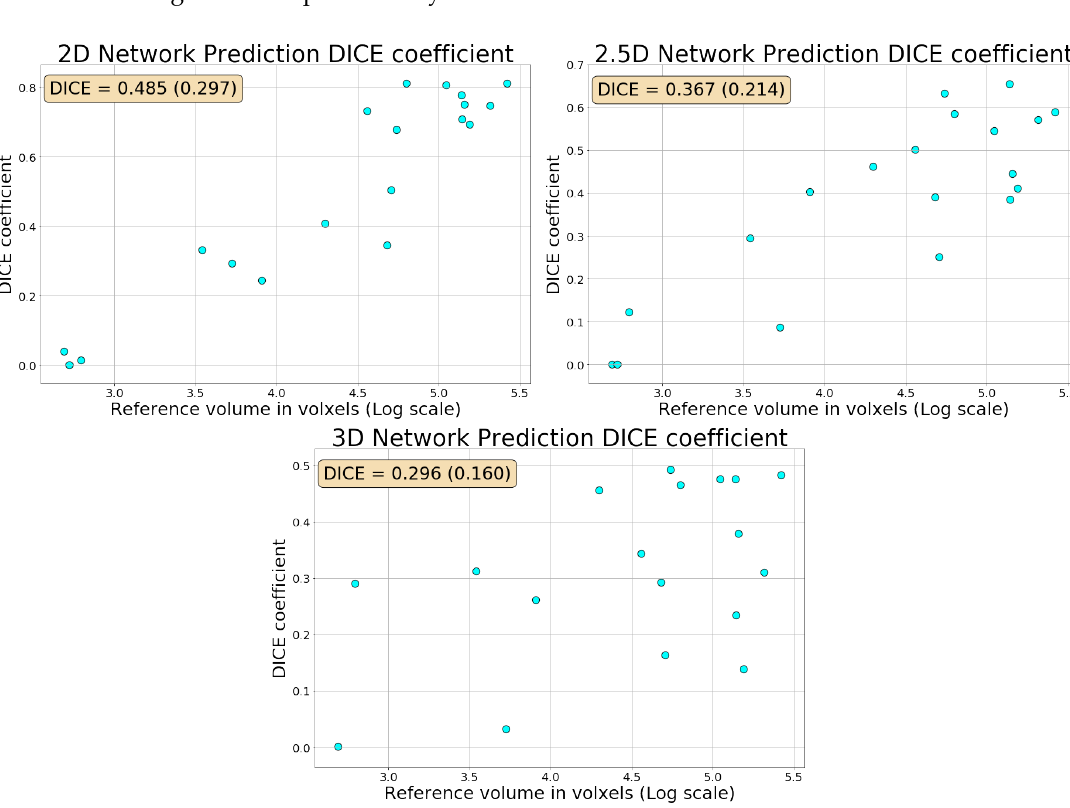
Figure A1. Comparison plot between per scan Dice coefficient and the total reference emboli volume in logarithmic scale using 2 D , 2.5 D , and 3 D network